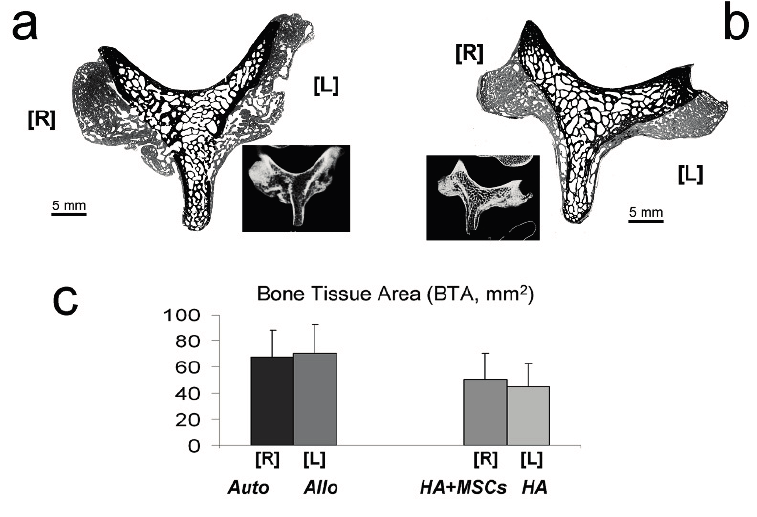
Figure 7. Bone histomorphometry. Examples of digitized images of cross-sectioned vertebrae from Auto- [R], and Allo- [L] groups ( a ); and HA + MSCs [R], and HA [L] groups ( b ), processed to measure new bone tissue area (BTA, in mm 2 ). Original pixel size was 5.2 µm. Insets show correlated axial CT scans; in ( c ) a graphic representation of those measures is